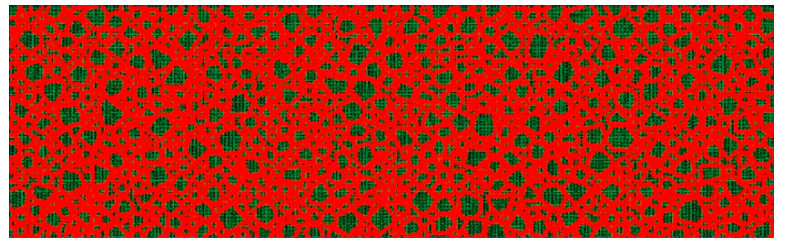
Figure 4. Random aggregates model.